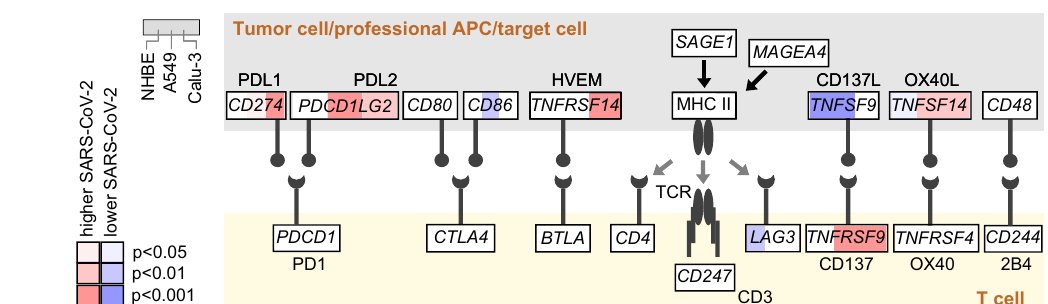
Figure 6. The SARS-CoV-2 transcriptional signatures are manifested in subsets of human lung cancer involving the immune checkpoint pathway. ( a ) RNA-seq profiles of 1023 Non-Small Cell Lung Cancer (NSCLC) cases 16 were probed according to the SARS-CoV-2 transcriptional signatures. Differential SARS-CoV-2- associated expression patterns common to all three cell lines (NHBE, A549, Calu-3) or found for just one or two cell lines (from Fig. 2b,c) are shown for both the in vitro SARS-CoV-2 infection dataset and the NSCLC dataset (“normal adj lung”, normal adjacent lung tissue samples in proximity to lung tumor, n = 110). Gene order is the same across both datasets. The ordering of NSCLC profiles is by nine previously-identified molecular subtypes 16 , three associated with lung squamous cell carcinoma (SqCC) and six associated with lung adenocarcinoma (AD). Heat map contrast (bright yellow/blue) is threefold change from control for SARS-CoV-2 dataset and 1 SD from median for NSCLC dataset. Selected patterns of manifestation of SARS-CoV-2 signatures within the human cancers are highlighted. Under the differential expression heat maps, scores for each SARS-CoV-2 signature across the NSCLC profiles are represented (orange-cyan heatmap). Gene expression-based signatures of immune cell infiltrates 38 and PDL1/PDL2 genes are also represented in both SARS-CoV-2 and NSCLC datasets (NK cells, natural killer cells). ( b ) Diagram of immune checkpoint pathway (featuring interactions between T cells and antigen-presenting cells, including tumor cells), with differential expression patterns in response to SARS-CoV-2 infection in each of the three cell lines represented (left, NHBE; middle, A549; right, Calu-3). Red, high in SARS-CoV-2-infected group versus control. p values by t test using log-transformed values. Most all of the genes represented where previously found elevated across the AD.2, AD.3, and AD.4 NSCLC subtypes 16